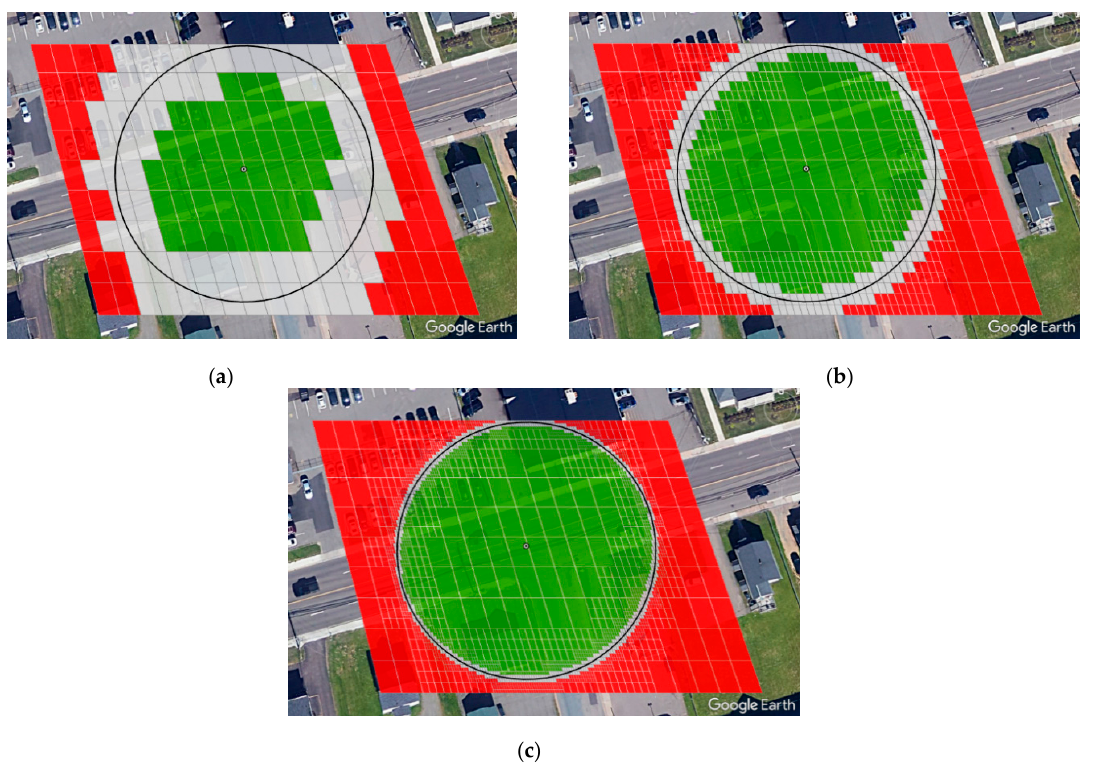
Figure 9. An offset region with 30 m radius and fringe cells of the multiresolution method at resolution ( a ) 13, ( b ) 14, and ( c ) 15 (shown in light grey). Cells marked as fully outside the offset region are shown in red and cells marked as fully inside the offset region are shown in green (©2020 Google Earth).